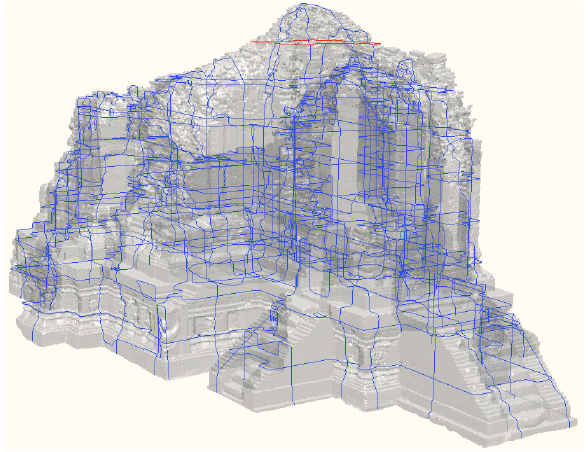
Figure 3. Height analysis based on religious considerations Figure 2. Extraction of horizontal and vertical sections from the according with a monk of the group accompanying the mesh model of the Kalan ruin